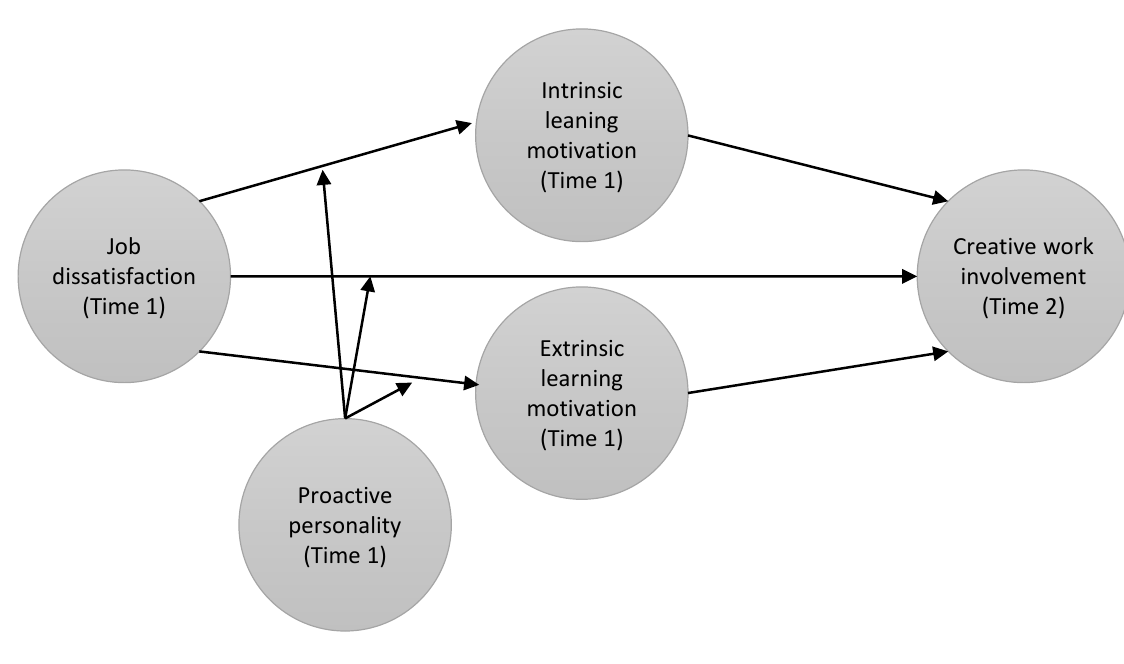
Figure 1. Research